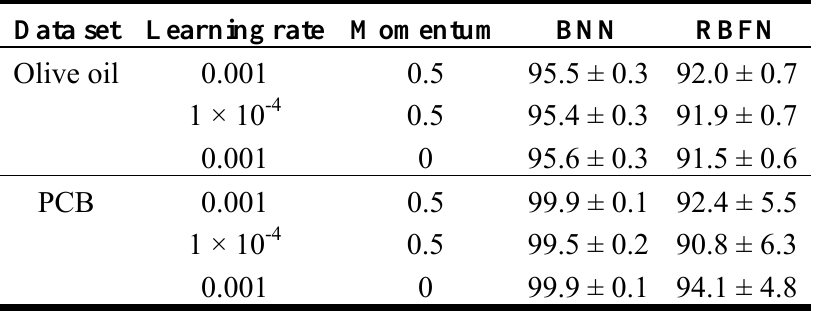
Table 2. Average prediction accuracies of the BNN and RBFN models with 95% confidence intervals of Italian olive oil and the PCB data sets. The BNN and RBFN were trained by three different sets of learning rates and momenta with 30